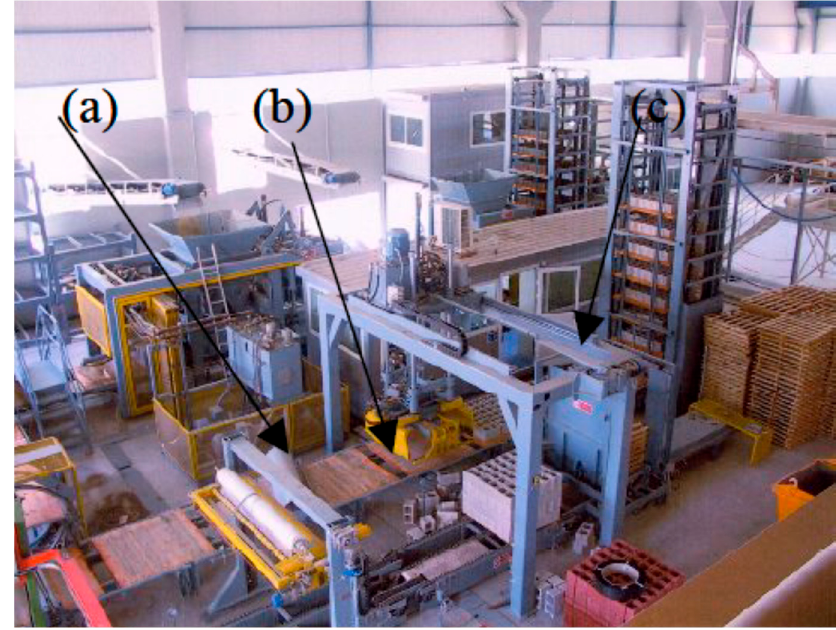
Figure 5. Example of production chain of blocks: ( a ) plate of fresh mix design; ( b ) vibro-compression mold box; ( c ) curing area.